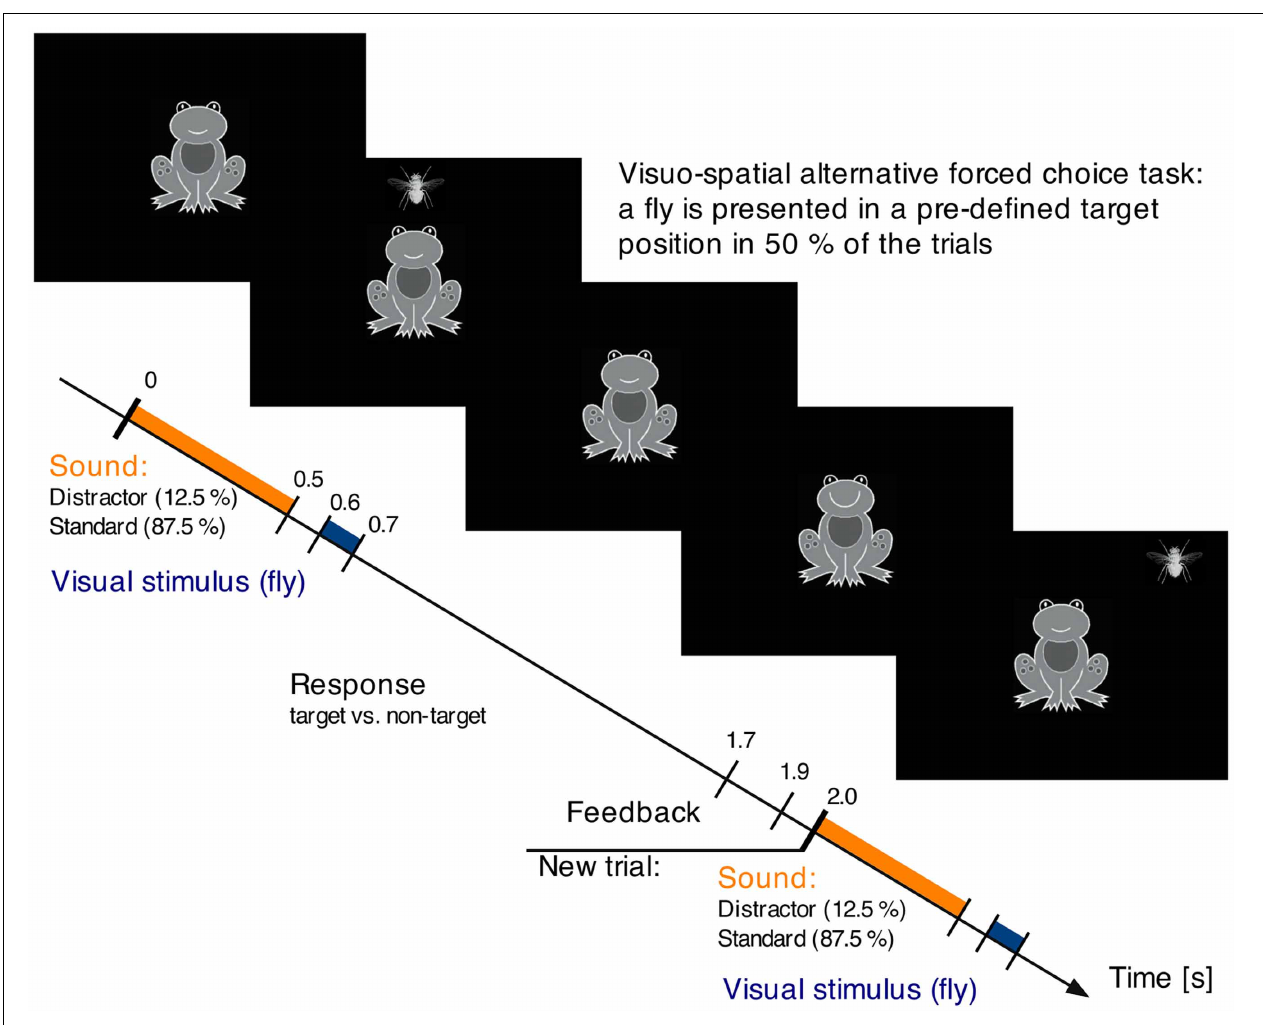
FIGURE 1 | Auditory-visual paradigm. The participant’s task is to respond to the visual stimulation and indicate whether a stimulus occurs in a target position or not. Target and non-target position appear with equal